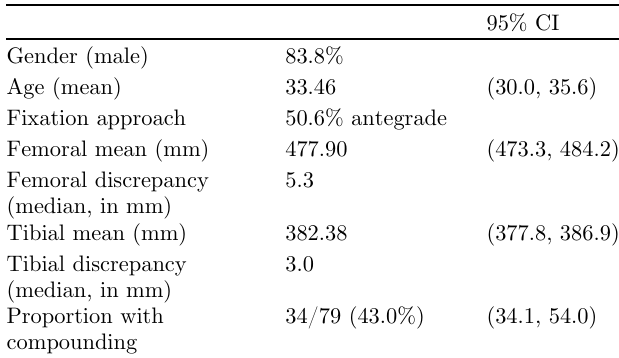
Table 1. Descriptive statistics of demographics, surgical method, and limb